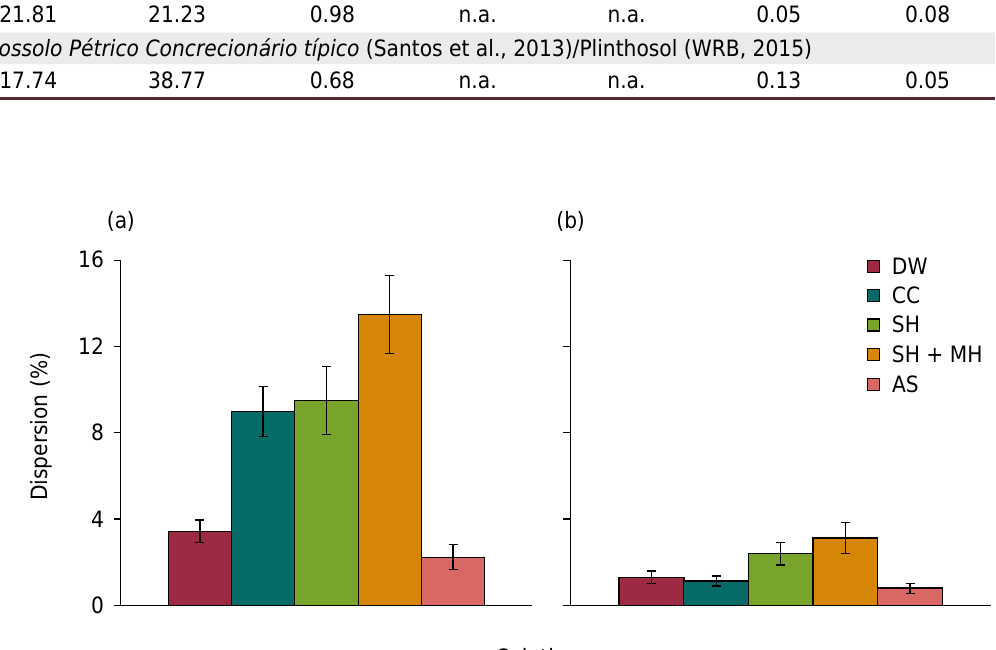
Figure 2. Mean value and standard error of the mean dispersion of plinthite (a) and petroplinthite (b) (95 % confidence interval; p<0.05). DW: distilled water; CC: calcium carbonate; SH: sodium hydroxide; SH + HM: sodium hydroxide + sodium hexametaphosphate; AS: acid solution.